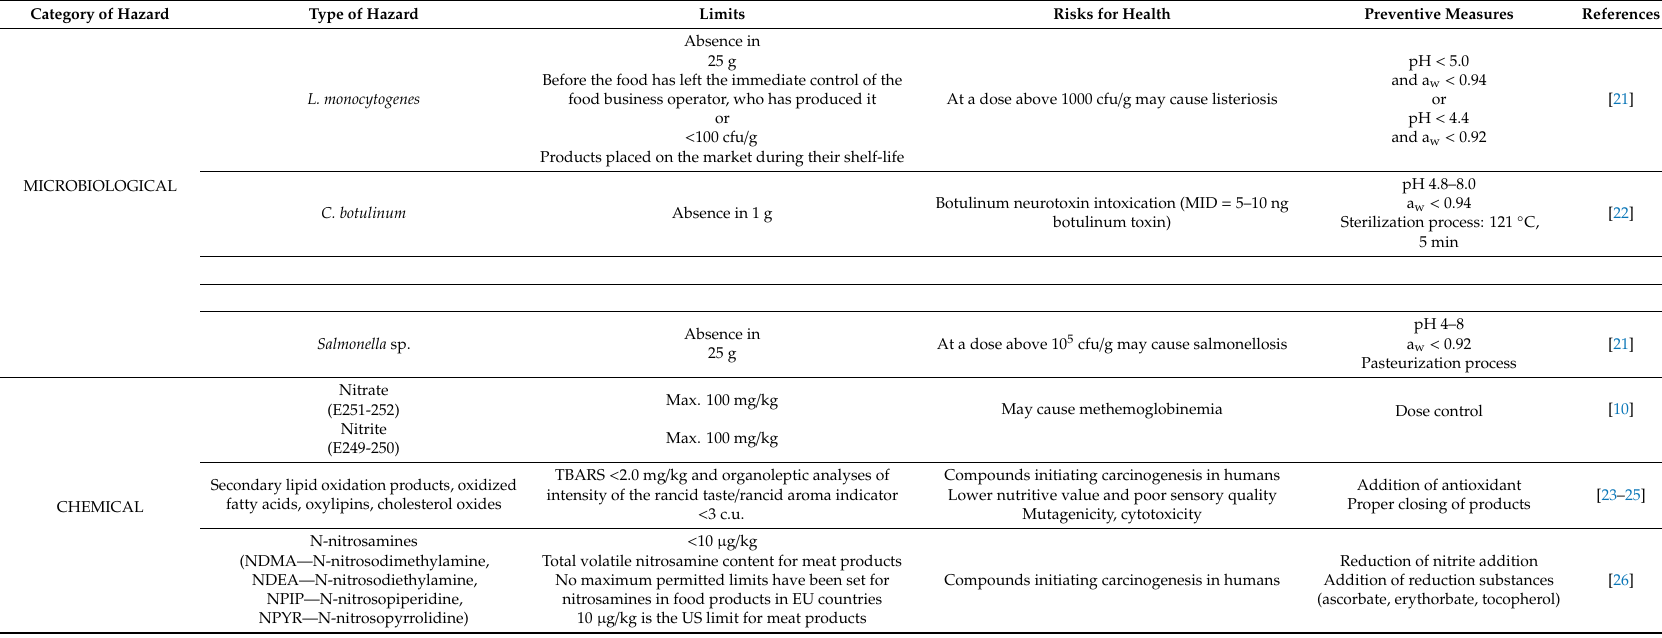
Table 1. Main microbiological and chemical substances of safety concern, their mechanism of generation, and health